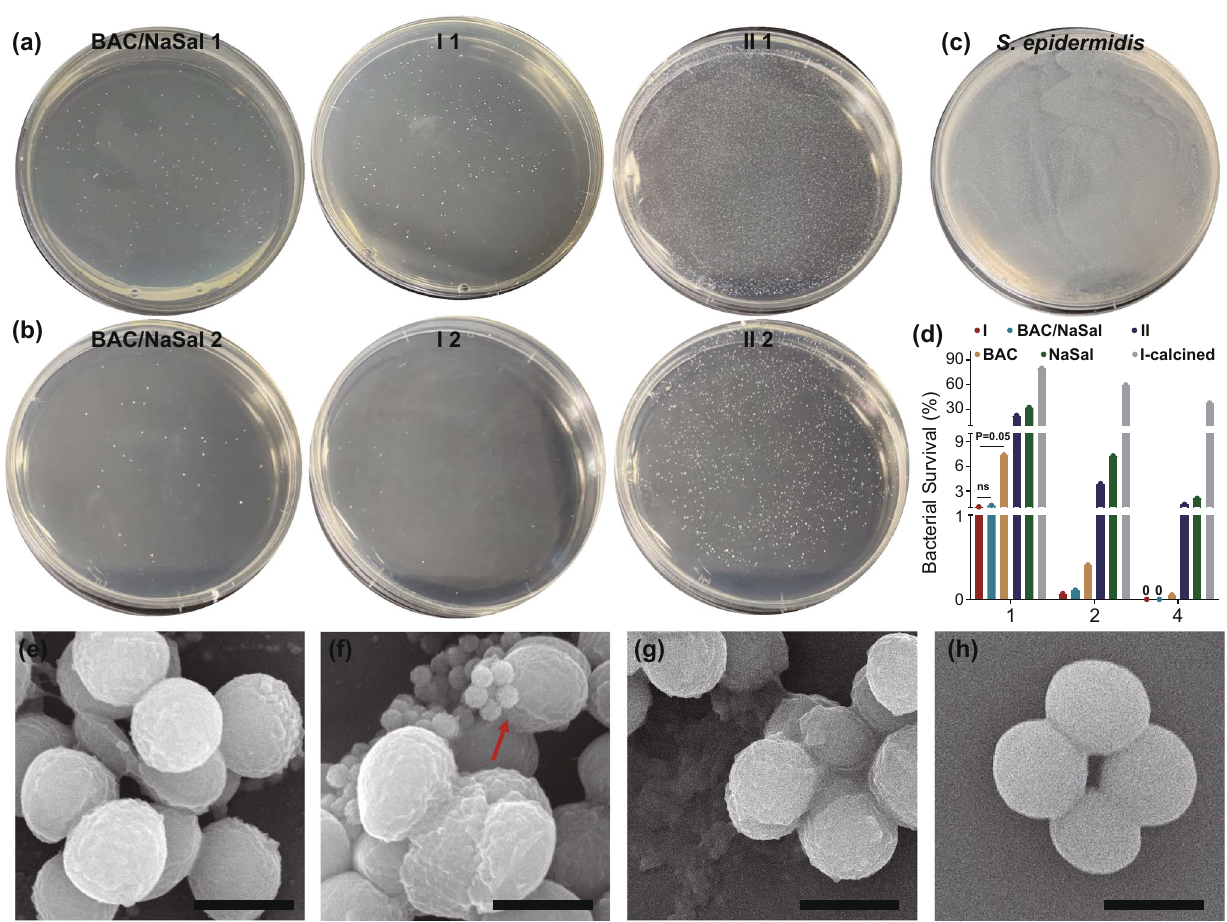
Fig. 2 a , b Dose-dependent killing of S. epidermidis by BAC/NaSal, nanocomposites I and II . Photographs of plates containing treated culture, where 1/2 represents the BAC concentration of each group. c Photograph of plate containing tenfold serial dilutions of untreated culture. d the average survival percentage of S. epidermidis upon exposure to each group quantified based on 1, 2 and 4.μg BAC mL −1 Statistical significance is calculated using a two-tailed t test with significant p-values shown. “ns” denotes “not significant.” e – h SEM images of BAC/NaSal, nanocom- posite I , nanocomposite II treated bacterial and untreated S.Epidermidis. (red arrows refer to a semi-spherical dent on bacterial surface upon adhesion of nanocomposite I ; scale bar: 1